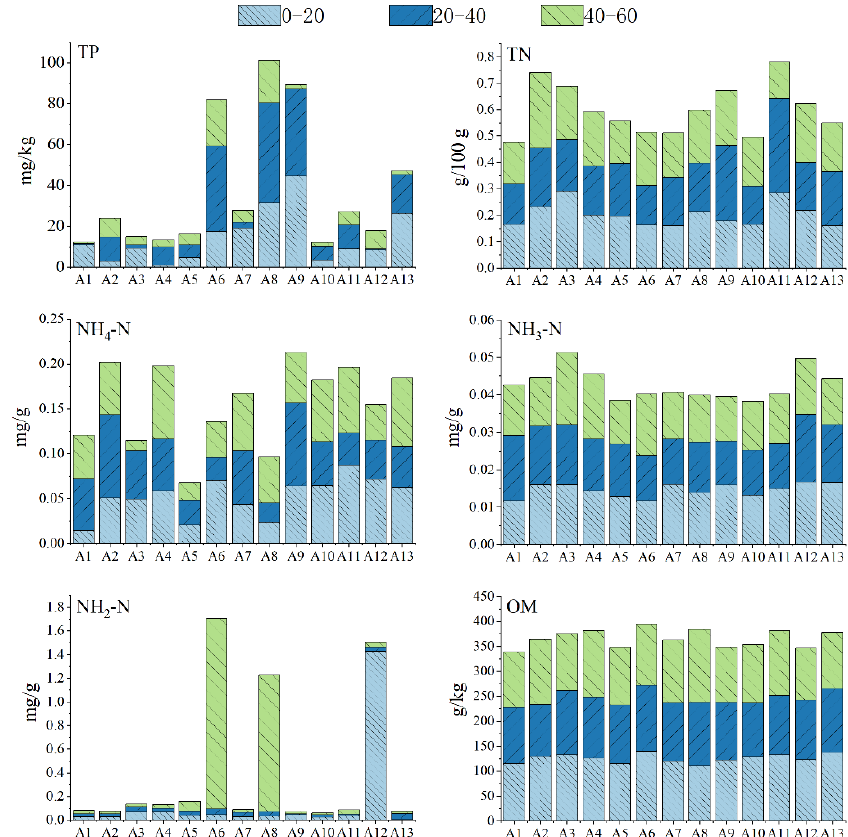
Figure 3. Basic environmental parameters in sediments of the North Canal.